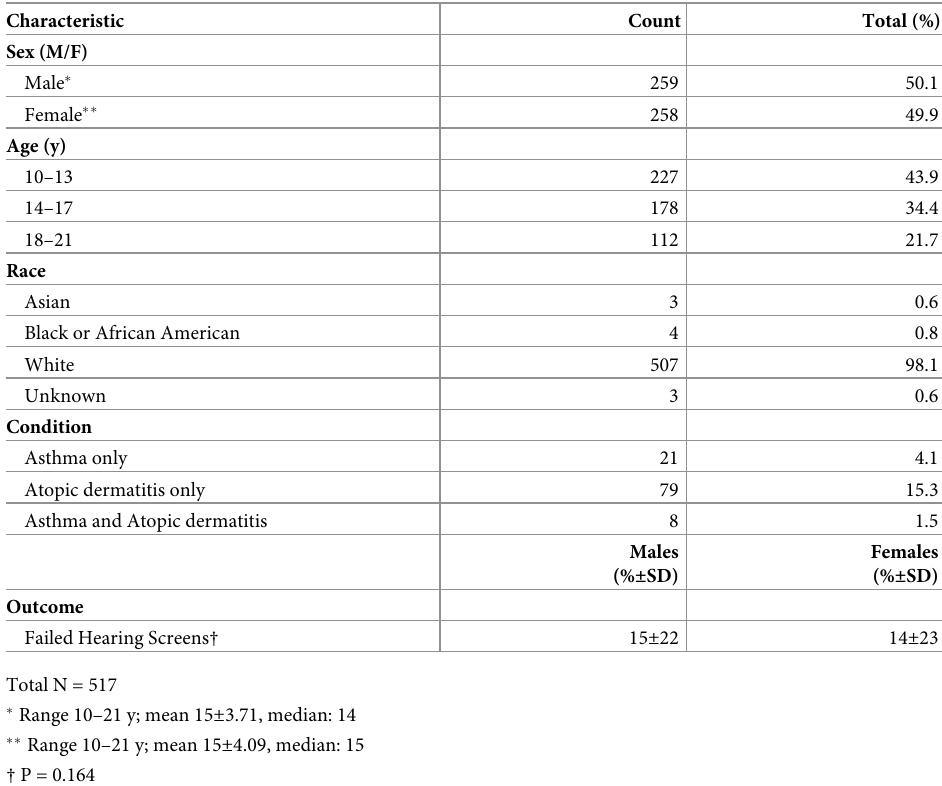
Table 1. Demographics and clinical characteristics of study